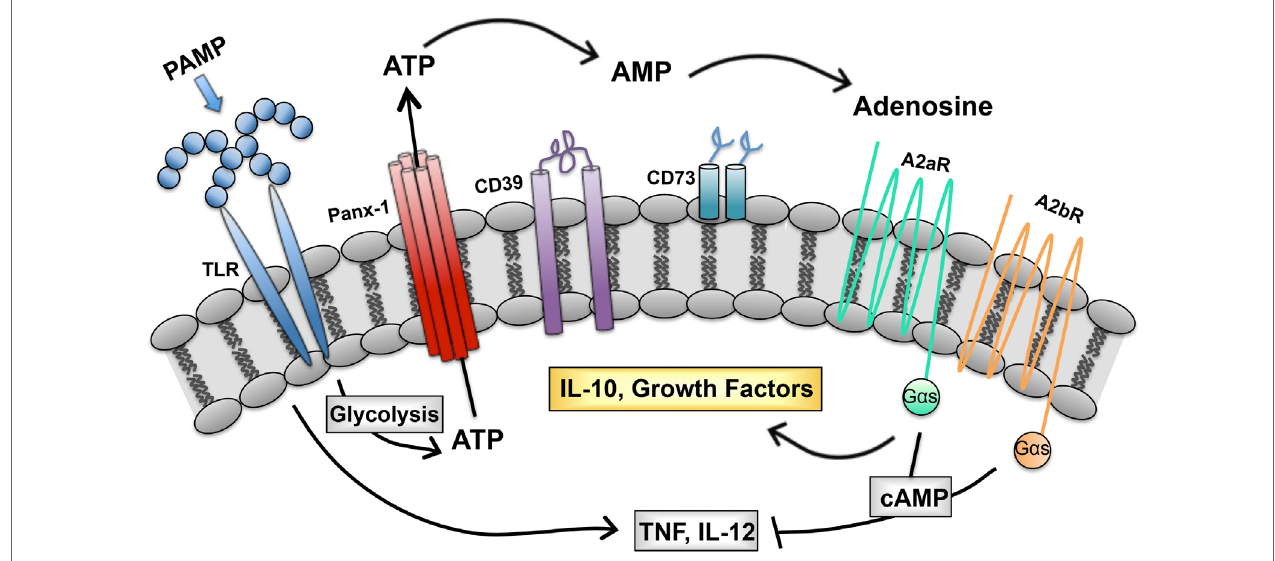
FiGURe 1 | Purinergic autoregulatory signaling in macrophages . Intracellular ATP, generated in response to pathogen-associated molecular patterns (PAMPS), is released from macrophages and converted to adenosine by the concerted action of CD39 and CD73. Adenosine signals through seven transmembrane receptors to terminate the production of inflammatory cytokines and to promote the production of IL-10 and growth factors